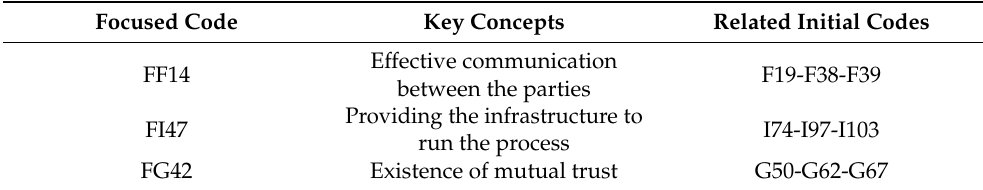
Table 3. Examples of focused codes.